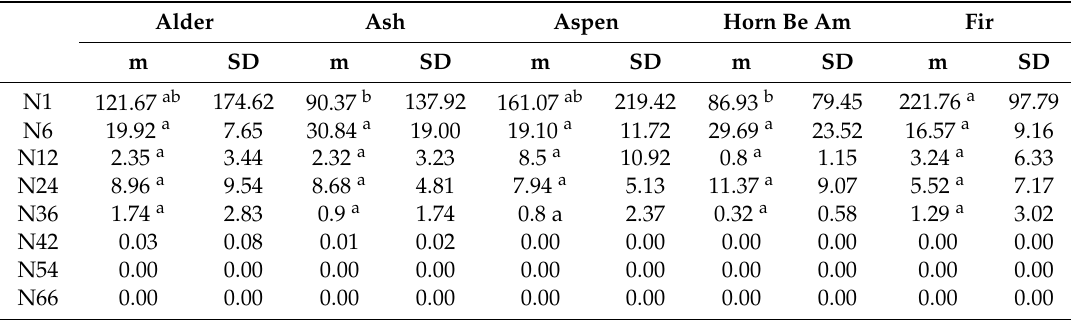
Table 4. Comparison of water absorbability for each species of deadwood. Alder Ash Aspen Horn Be Am Fir m SD SD